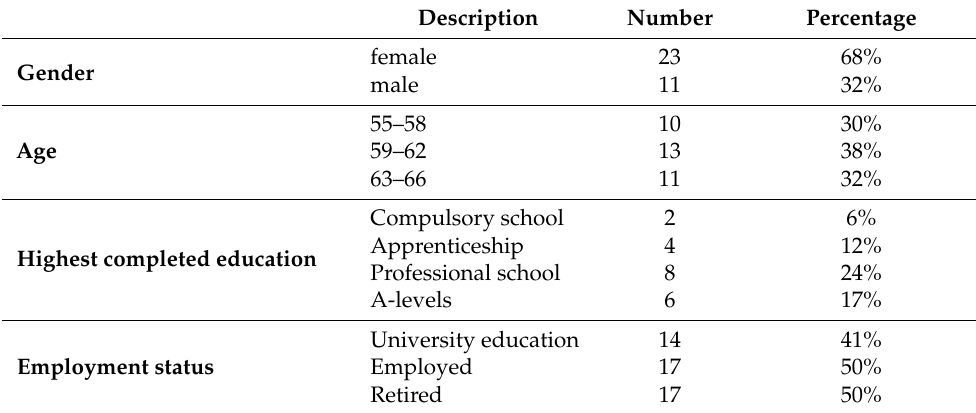
Table 2. Demographic profile of the participants ( n = 34).